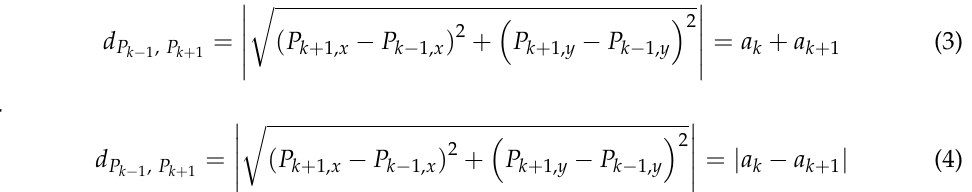
Figure 5. Symmetry of left- and right-handed solutions.